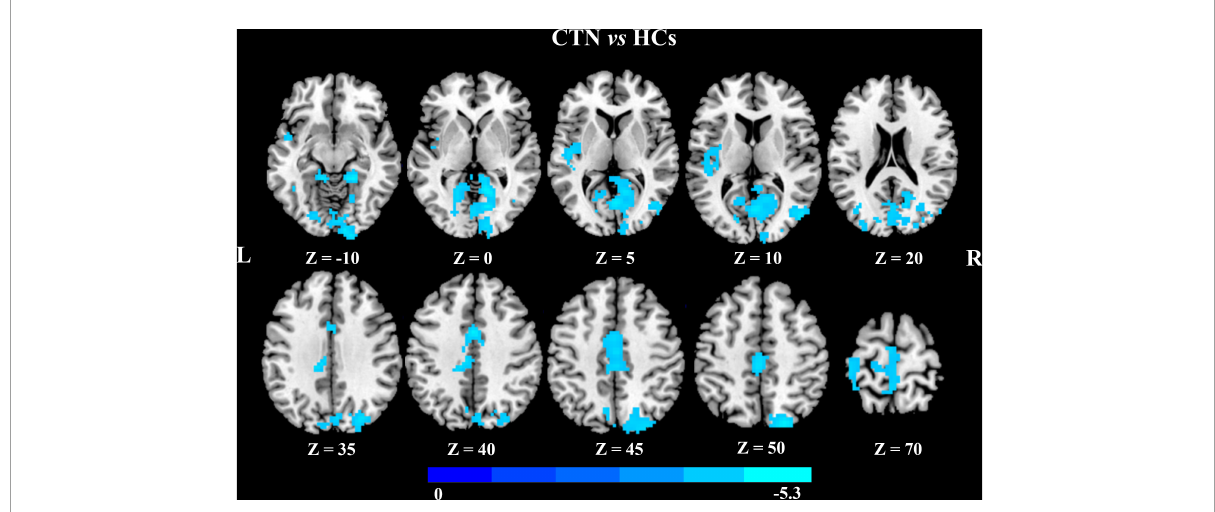
FIGURE3 Altered left midcingulate cortex FC in CTN patients. The CTN patients showed significantly decreased FC between the left midcingulate cortex and visual network, left paracentral lobule compared with HCs ( p < 0.05, FDR corrected, cluster > 100 voxels). FC, functional connectivity; CTN, classic trigeminal neuralgia; HCs, healthy control subjects; FDR, false discovery rate.